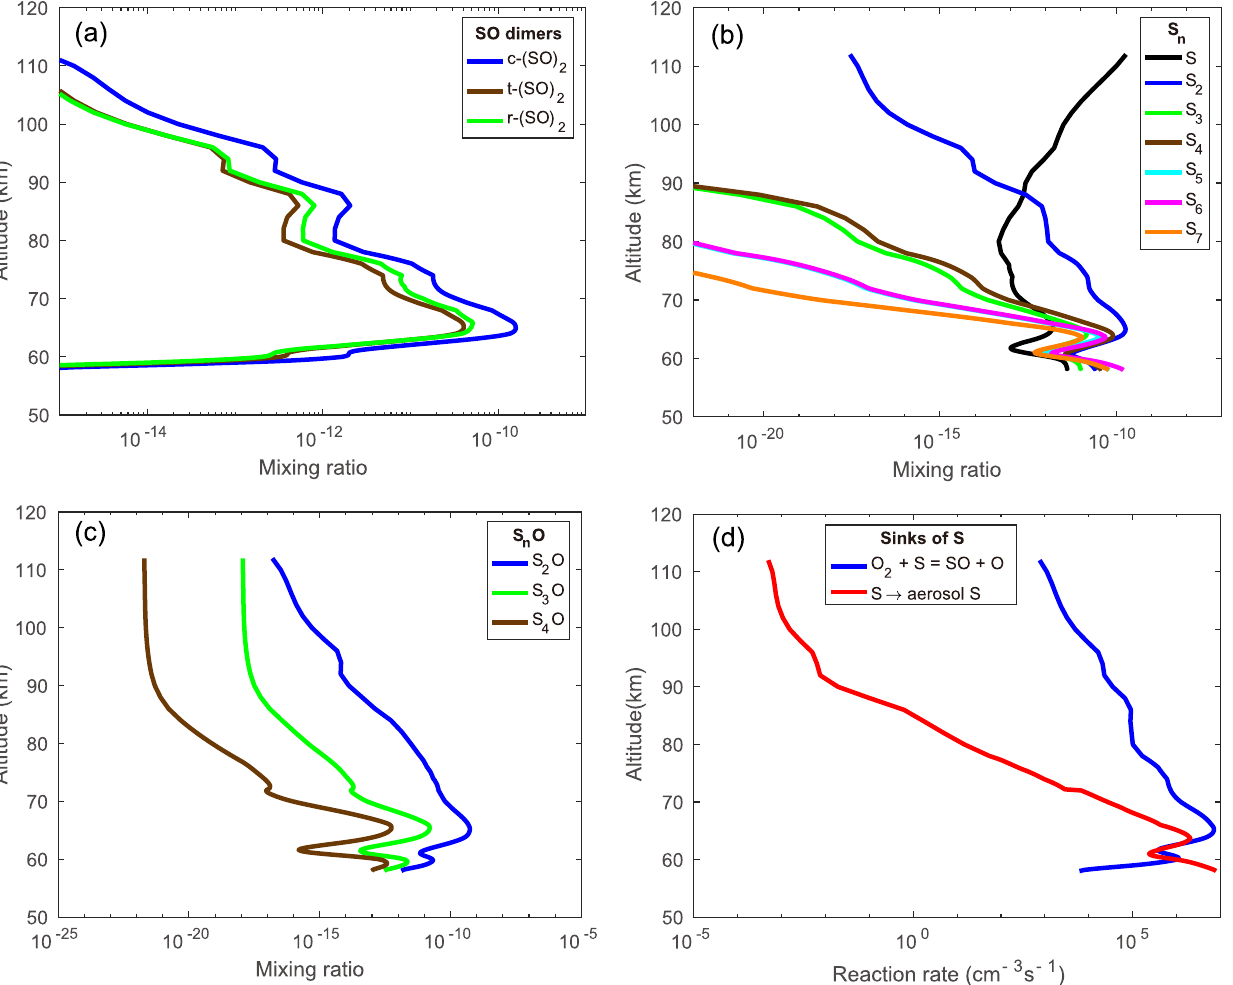
Fig. 2 Model results. a Modeled pro fi les of cis -(SO) 2 , trans -(SO) 2 , and trigonal-(SO) 2 . b Modeled pro fi les of S n species. c Modeled pro fi les of S 2 O, S 3 O and S 4 O. d Comparison of production of aerosol S versus recycling of S back to